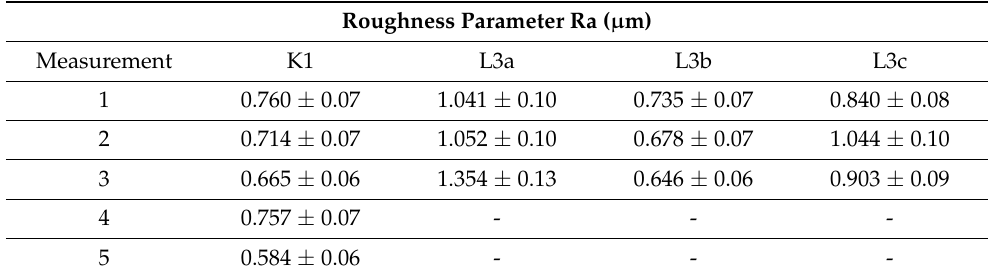
Figure 4. Surface microgeometry maps determined for the polished composites K1 (Enhance polishing pad), K2 (polishing pad, Sof-Lex™ Pre-Polishing Spiral (beige)), and K3 (polishing pad, beige polishing pad, pink polishing pad) before the laser irradiation process. Table 3. Roughness parameters determined for the K1, K2, and K3 composites before and after the laser irradiation process in three variants: L3a (60 s sweeping), L3b (2 × 30 s sweeping), and L3c (60 s point